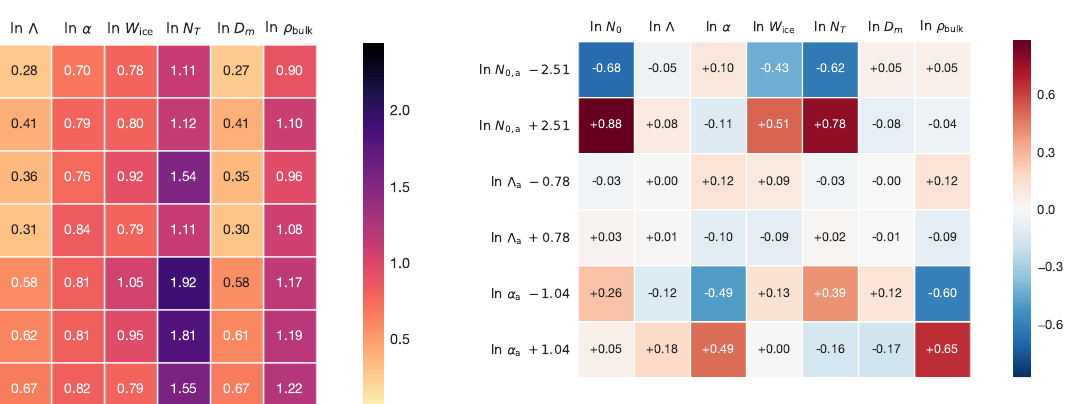
Figure 6. The root-mean-square changes in the microphysical pa- rameters in response to changes in the prior. The change in the prior is indicated on the left side of each row. The data are from the 4 De- cember 2015 case (Sect.